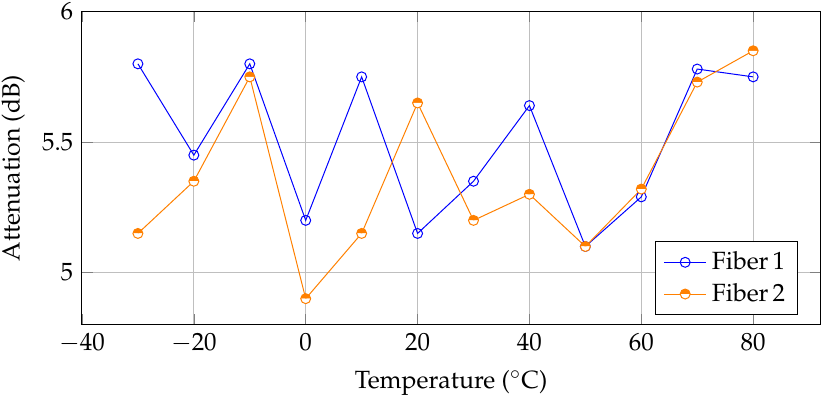
Figure 7. Influence of the temperature on the attenuation of the